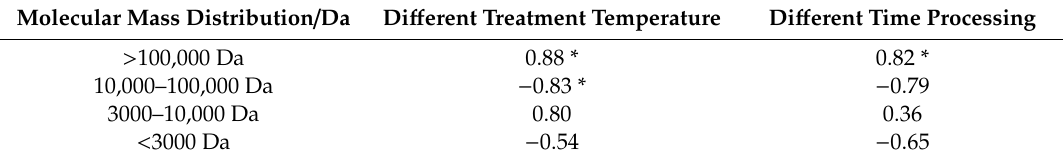
Table 3. The correlation between protein molecular distribution as a function of digestion SPIs and the DH at di ff erent heat